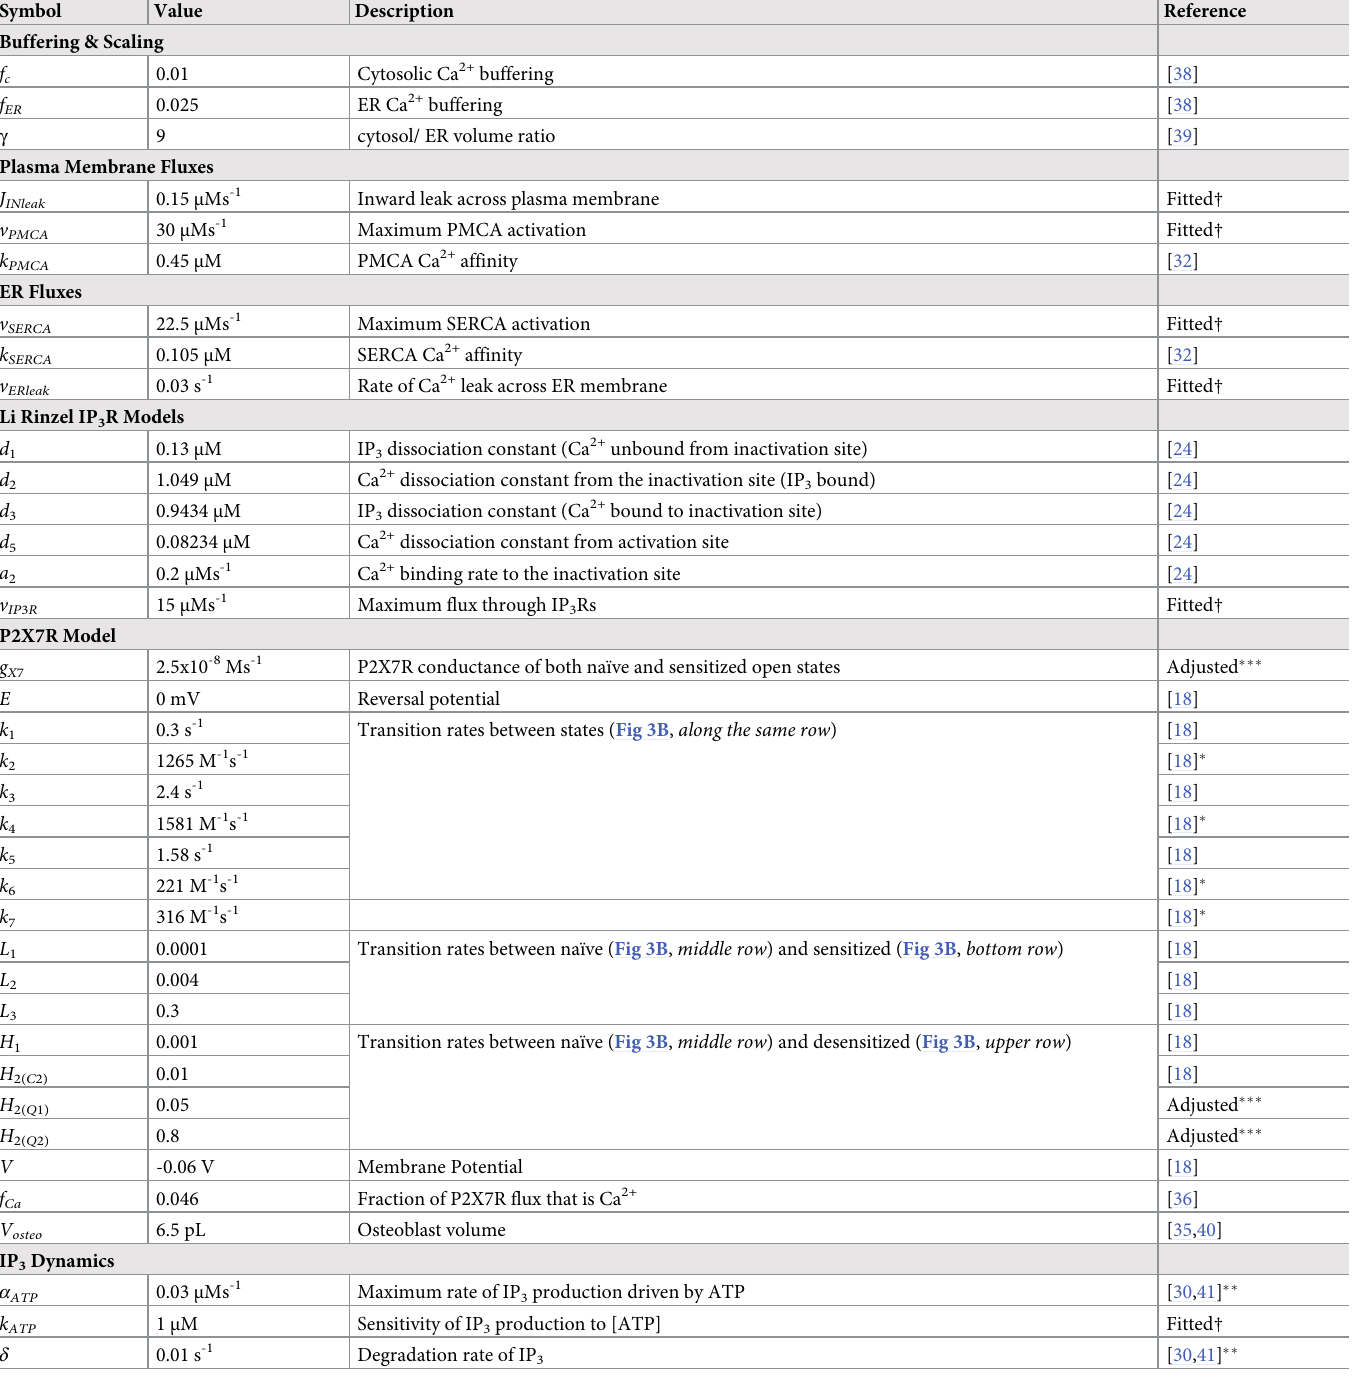
Table 1. Mathematical Model